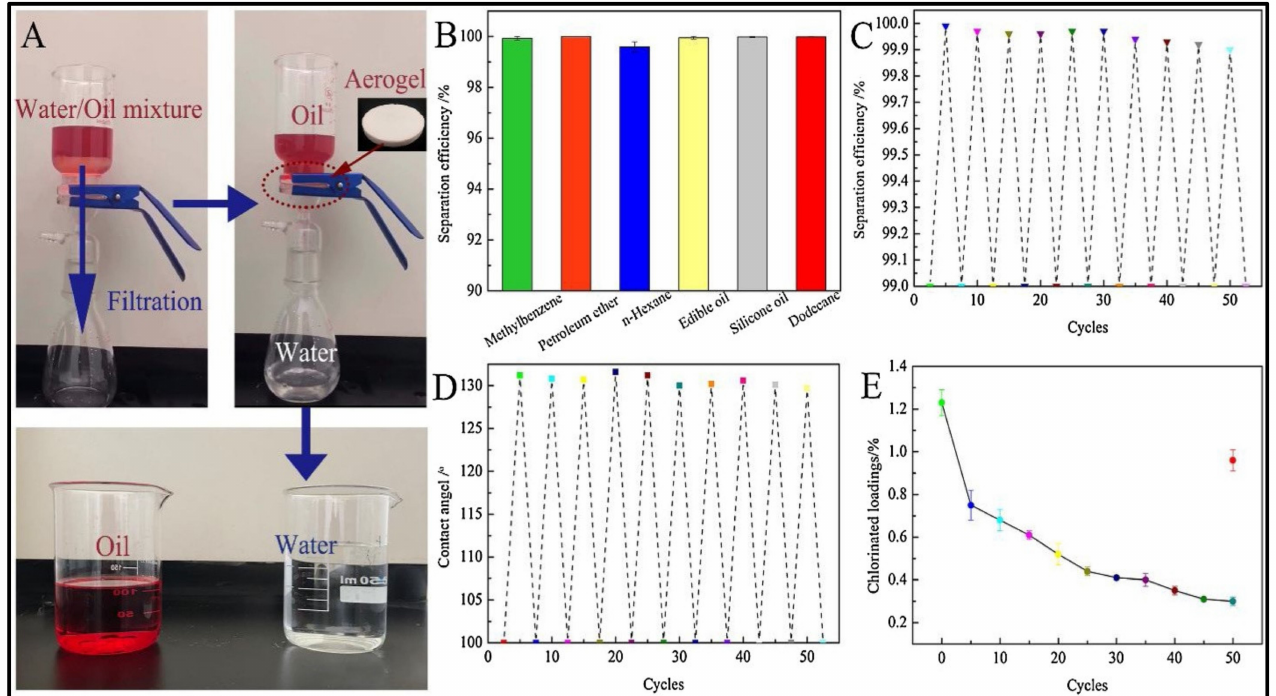
Figure 8. Illustration of the great performance of nanocellulose/chitosan aerogel in oil/water separa- tion, showing the separation of the two materials in high purity; ( A ) oil/water separation experiment, ( B , C ) separation efficiency values, ( D ) water contact angle, and ( E ) chlorinated loadings. Adapted from [113], with permission from Elsevier,